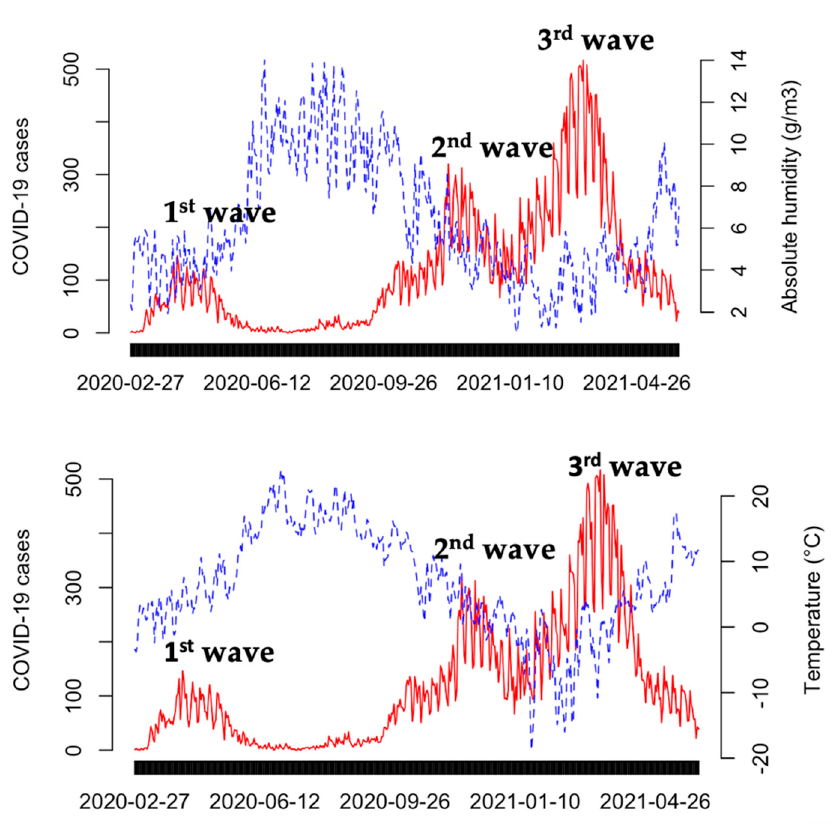
Figure 2. Daily average absolute humidity values ( upper figure ) and daily mean temperature ( lower figure ) with daily numbers of laboratory-confirmed COVID-19 cases (red color) in the Helsinki-Uusimaa Hospital District (HUS). Three epidemic wave peaks took place during the study